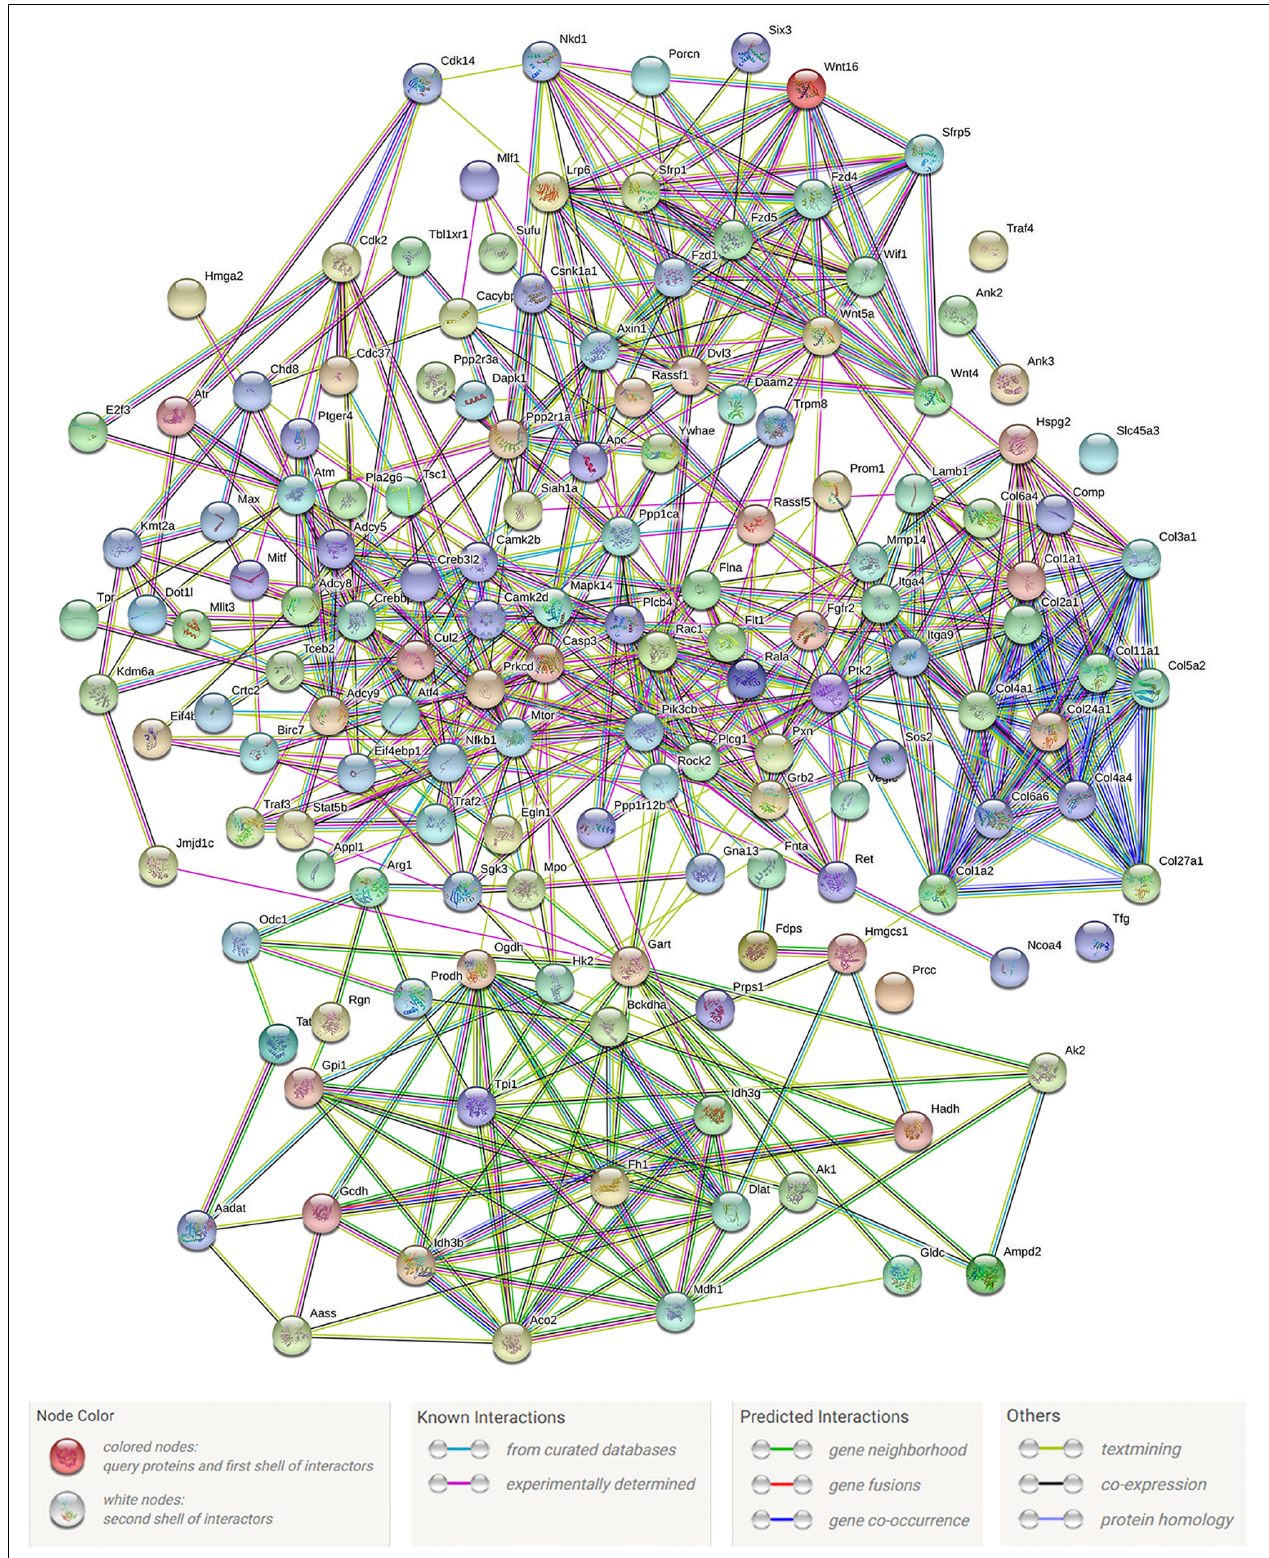
FIGURE 7 | Immune-related protein–protein interaction networks. Network nodes stand for proteins. The legend represents the relationships between nodes.